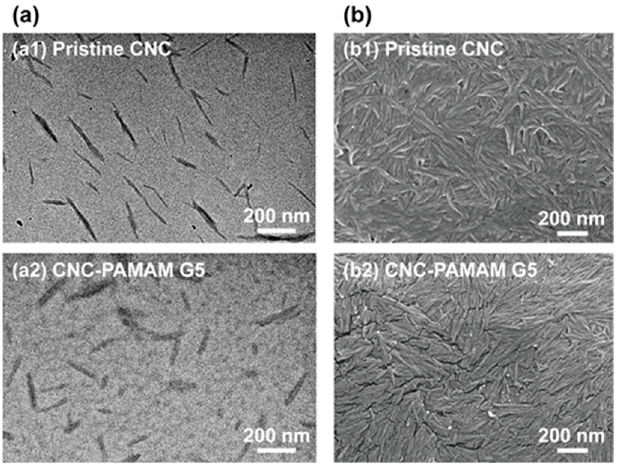
Figure 3. ( a ) TEM and ( b ) SEM images of the typical pristine CNC and CNC-PAMAM G5.